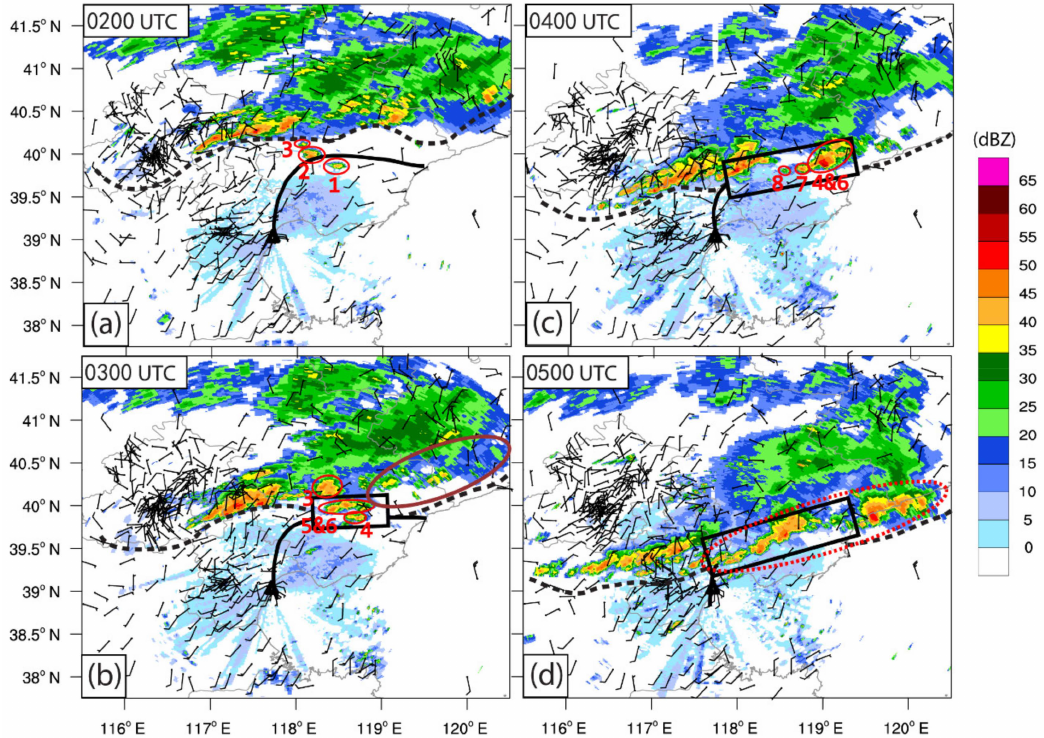
Figure 3. ( a – d ) Composite radar reflectivity (shading, units: dBZ) observed by Tianjin radar station (indicated by black triangle) and wind fields (half barbs and full barbs represent 2 and 4 m s − 1 , respectively) observed by ground-based automatic weather stations on 31 July 2010. The black solid lines indicate the locations of the SBF, and black dashed lines denote the locations of the GF. The black rectangle area indicates the merging area. The locations of the convections initiated near the merging area are indicated by red ellipses or circles, and the numbers in red indicate the sequence number of the newly initiated convective cells. The solid brown ellipse shows the area where the convective system significantly weakened and (or) dissipated. The dotted red ellipse denotes the mesoscale convective system (MCS) initiated and (or) developed due to the merger of the GF and SBF. The specific time is shown in the upper left corner of each